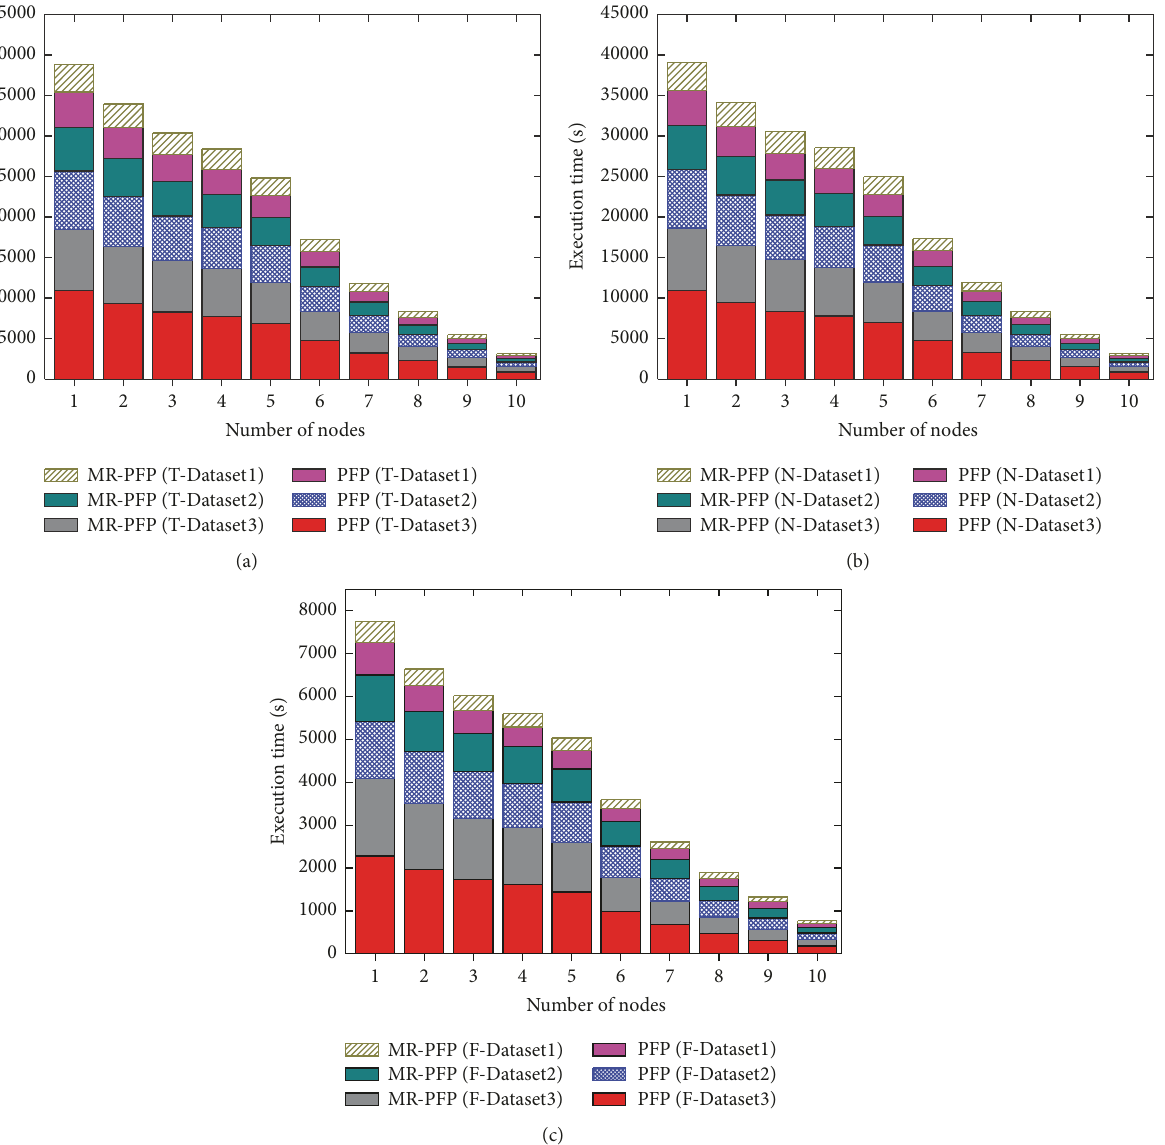
Figure 6: Execution time of MR-PFP and PFP. (a) T-Datasets, (b) N-Datasets, and (c)